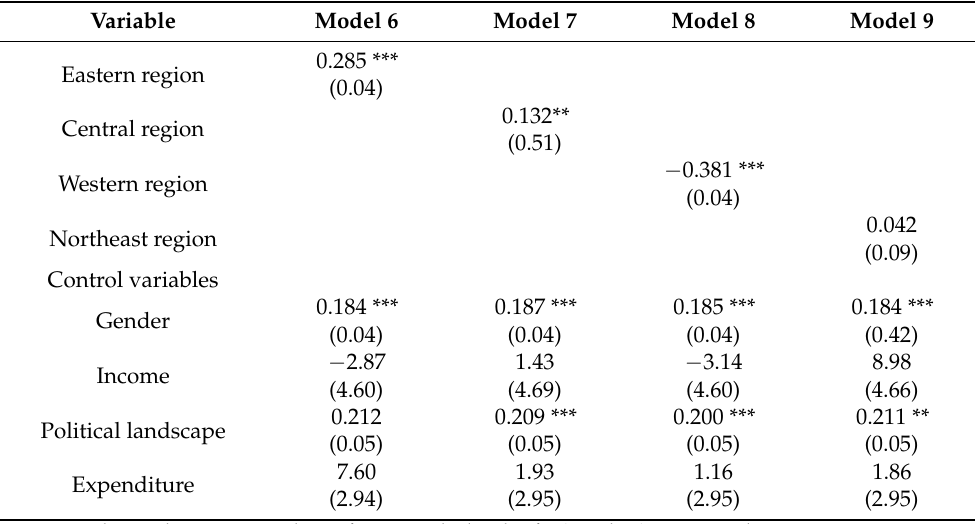
Table 3. Heterogeneity of social capital’s effect on farmers’ willingness to adopt new agricultural technologies in four